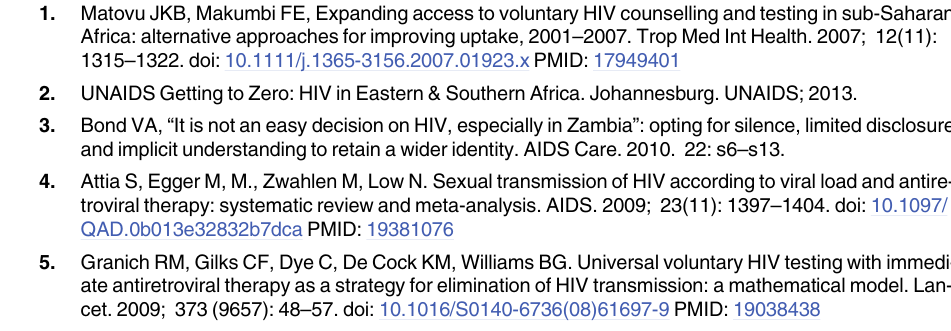
S1 Table. Quality and relevance assessment form. S2 Table. Thematic construct